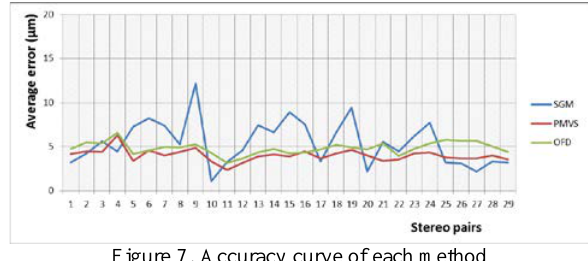
Figure 7. Accuracy curve of each method